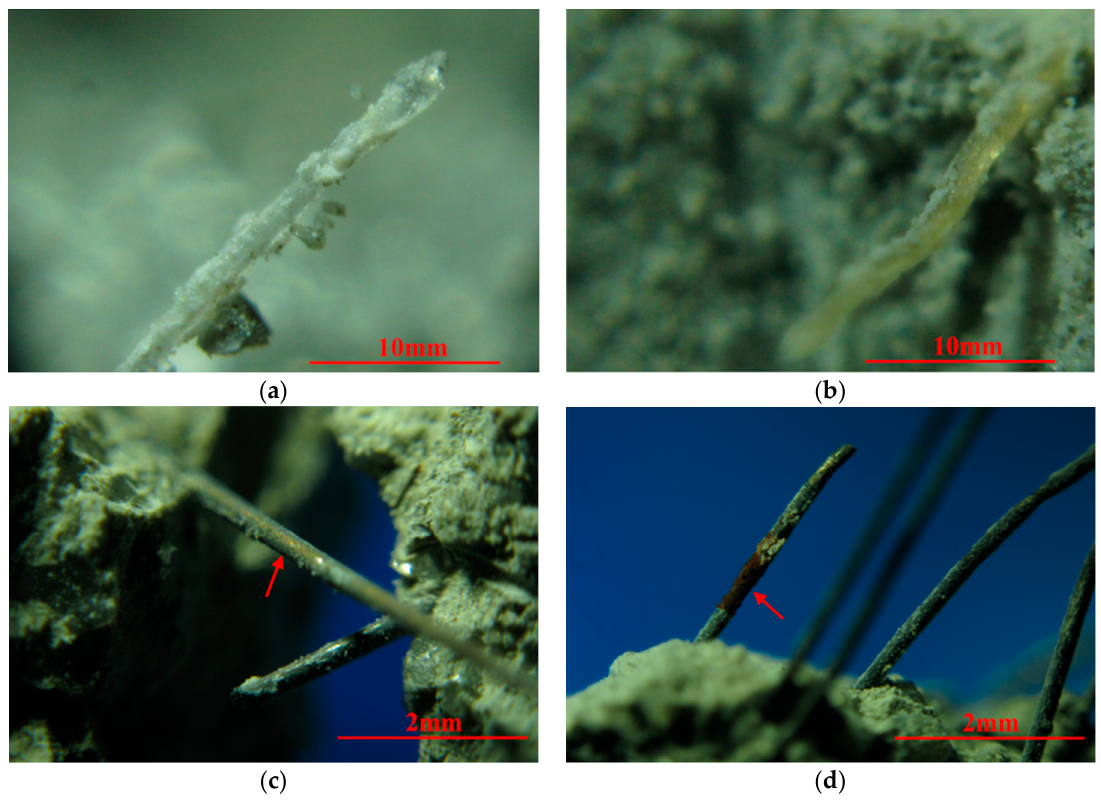
Figure 9. MSFRC at ( a ) Room temperature, ( b ) 200 °C, ( c ) 400 °C and ( d ) 600 °C under optical microscope.